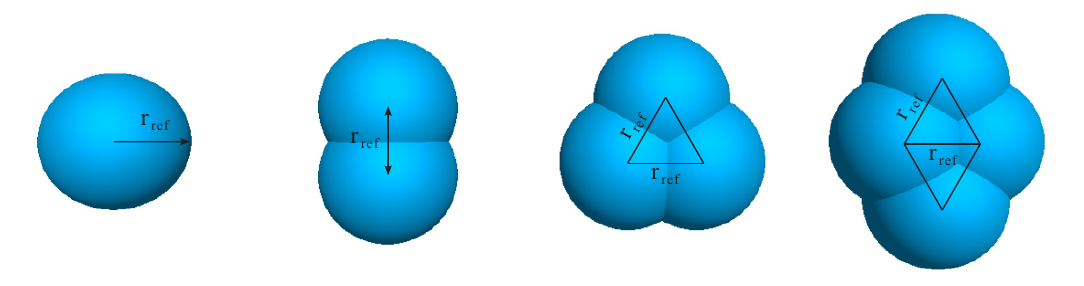
Figure 2. Clump templates used to model concrete